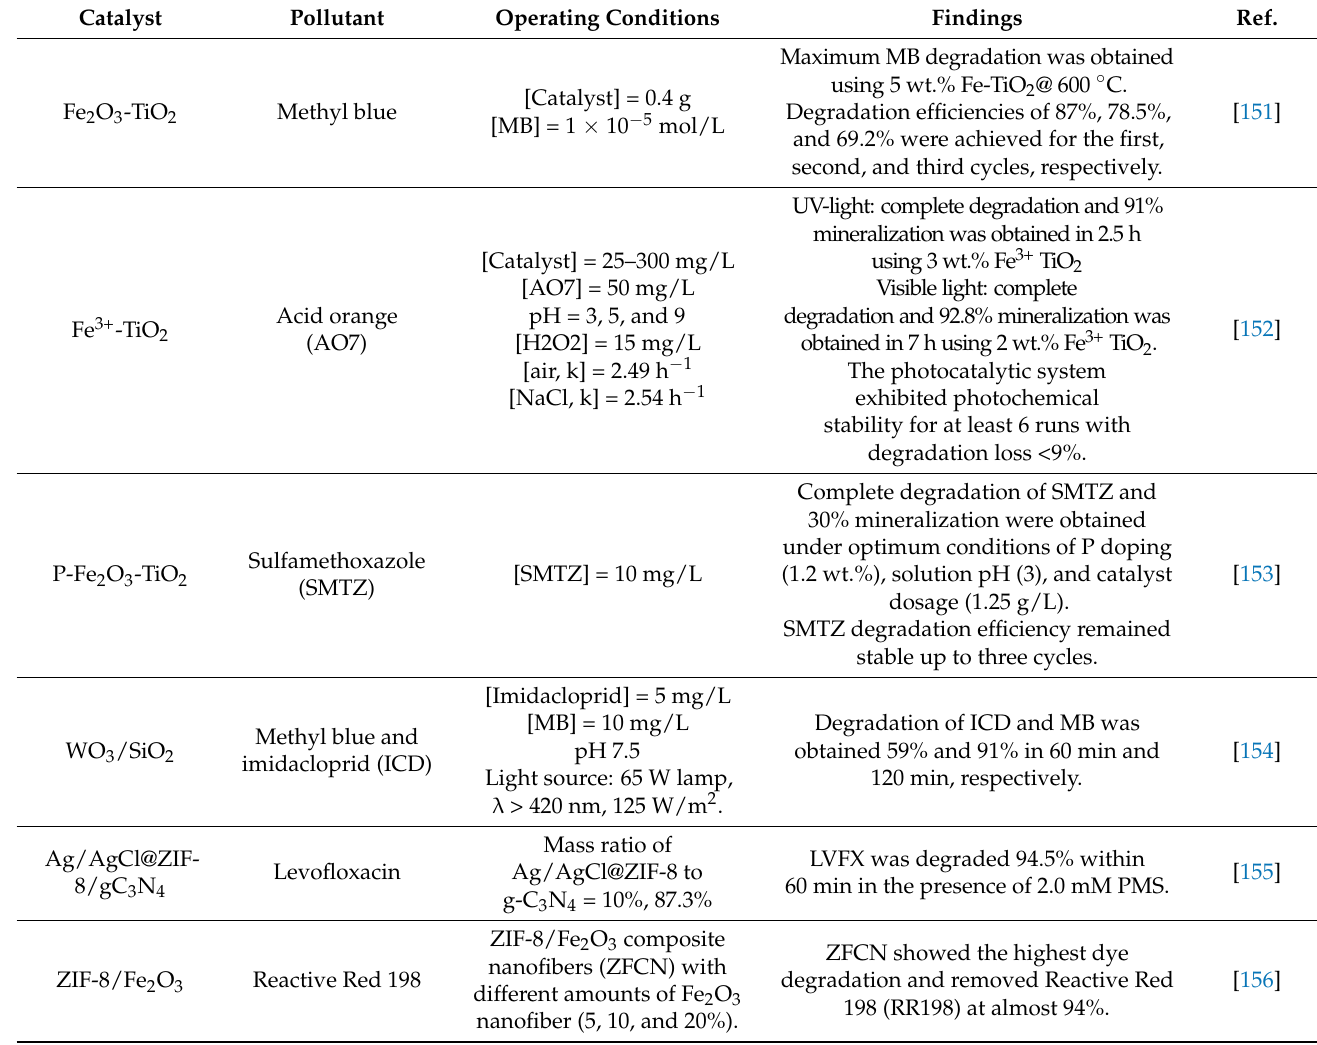
Table 2. A comparison of dye and antibiotic removal efficiency using different